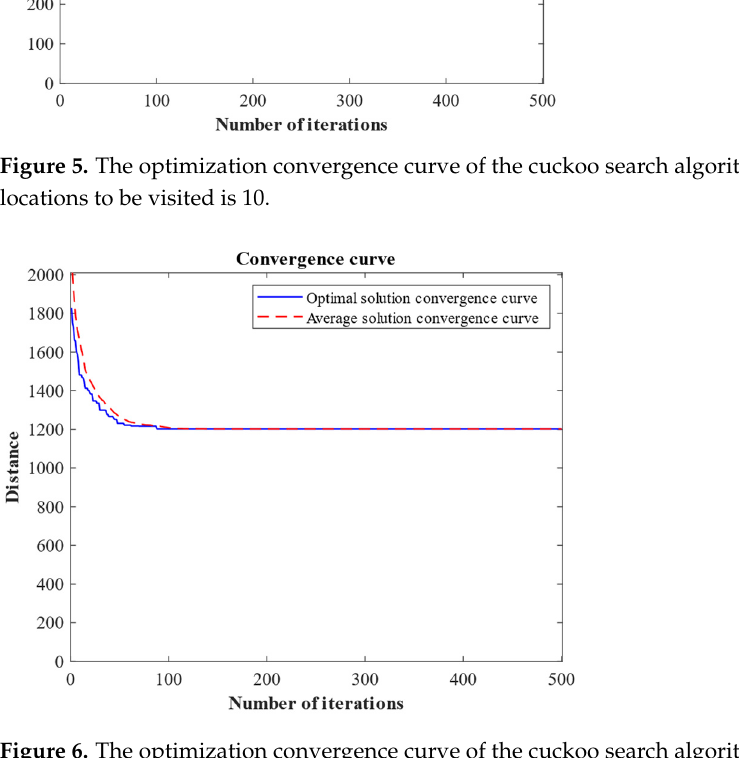
Figure 7. The optimization convergence curve of the cuckoo search algorithm when the number of locations to be visited is 30.